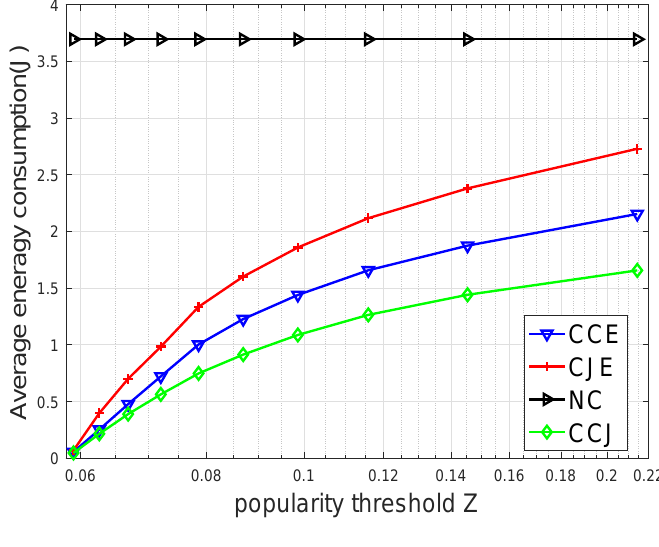
Figure 3. Average energy consumption on four schemes versus the caching popularity